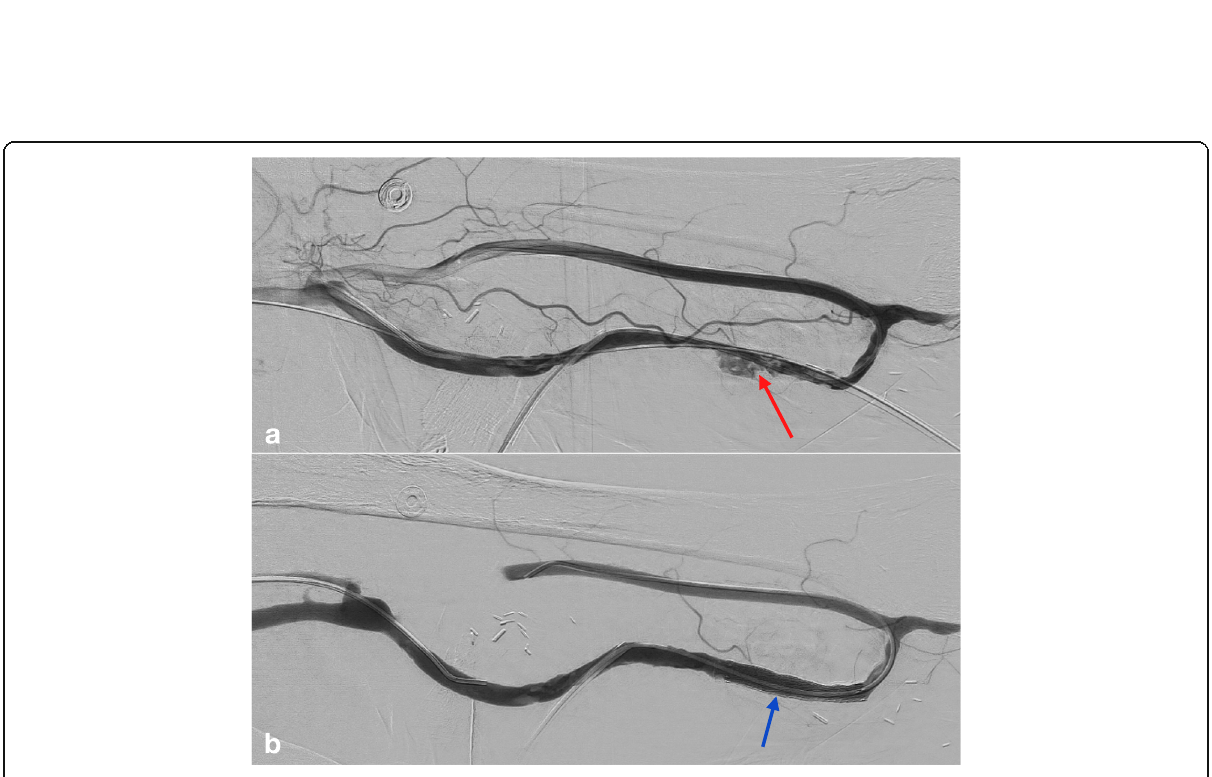
Fig. 3 Focal irregularity (red arrow) at the site of delamination, did not expand to suggest true extravasation ( a ) Final angiogram after placement of covered stent graft (Viabahn Endoprosthesis) (blue arrow) across the site of delamination showing correction of the focal irregularity and improved flow across the fistula ( b